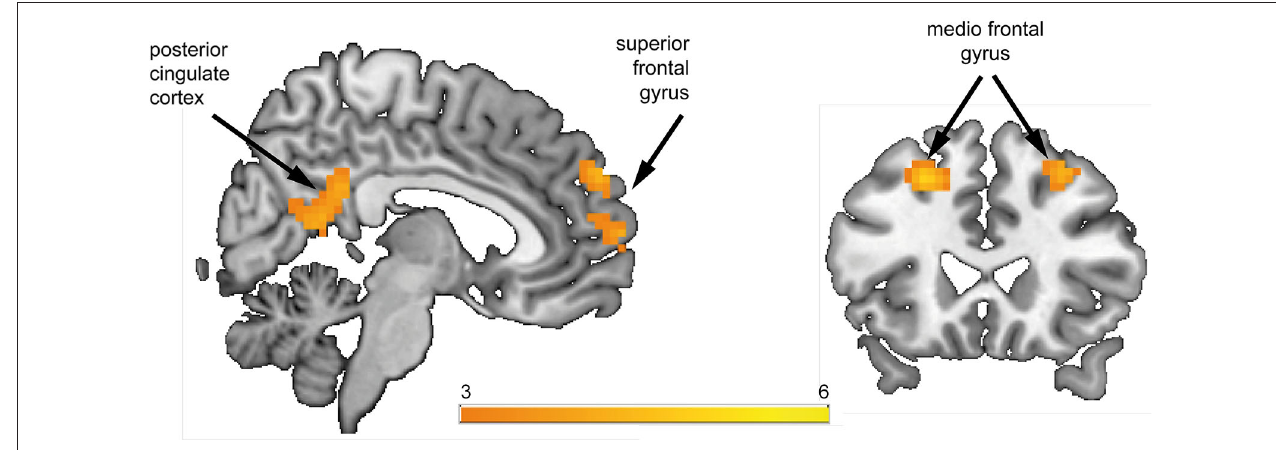
controls in the posterior cingulate cortex, superior frontal gyrus, and bilateral medio frontal gyrus (corresponding t -values are represented in